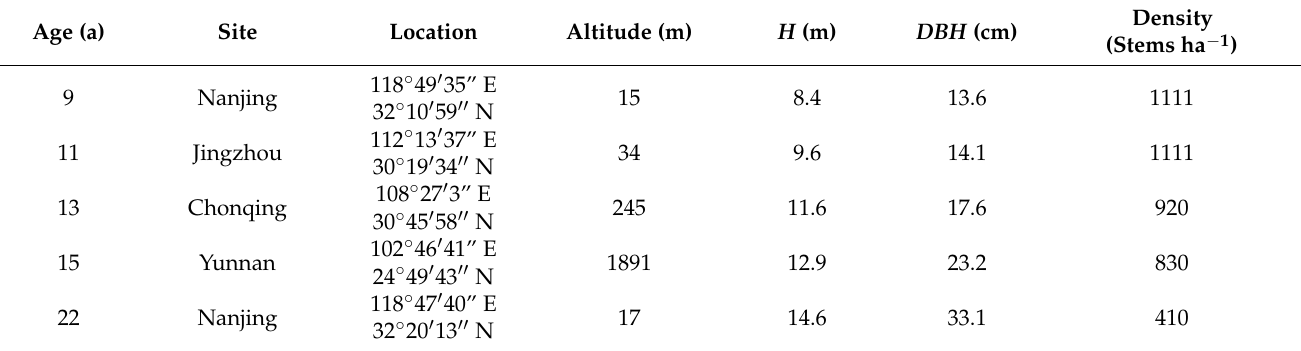
Table 1. Characteristics of the 9-, 11-, 13-,15- and 22-year-old T . Zhongshanshan